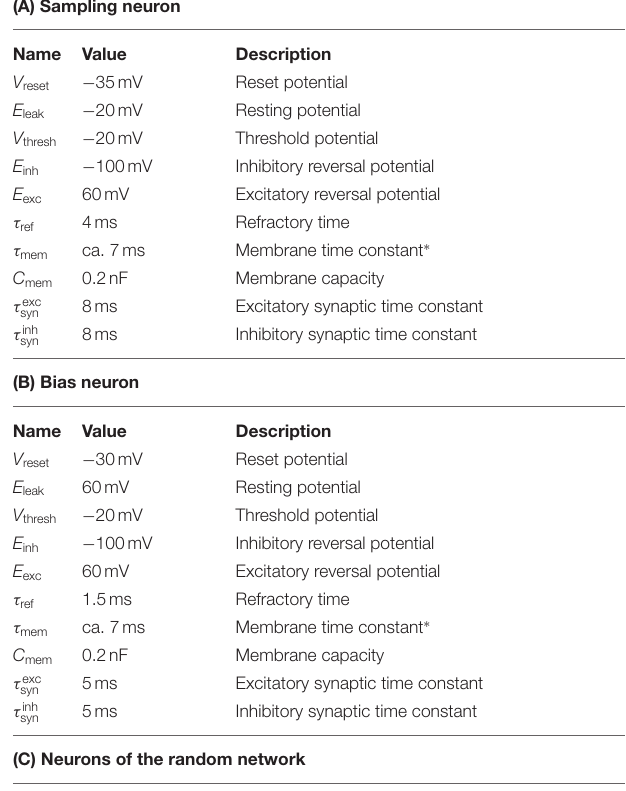
TABLE 2 | Neuron parameters. (A) Sampling